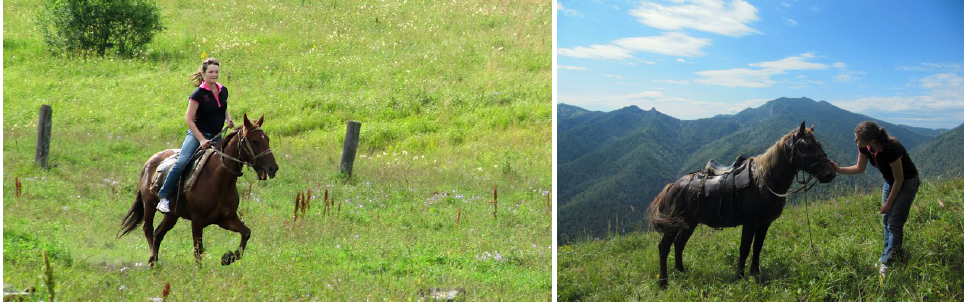
Figure 1. Is it possible to break the light speed barrier on horseback?